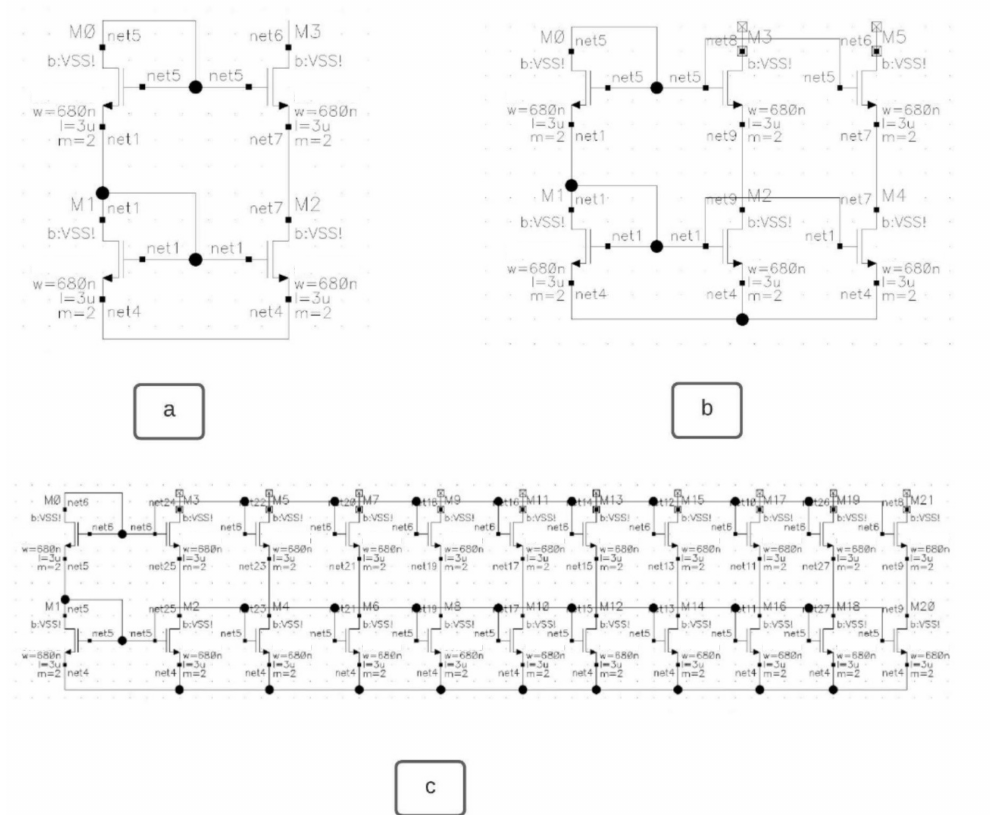
Figure 3. Example schematics samples of the same class “cascode current mirror bank (CCMB”). Different configurations are presented here: ( a ) 0 bank; ( b ) 1 bank; and ( c ) 9 banks. For each other class (in total we have 5 classes) within the dataset, there are similarly 10 topology/architecture